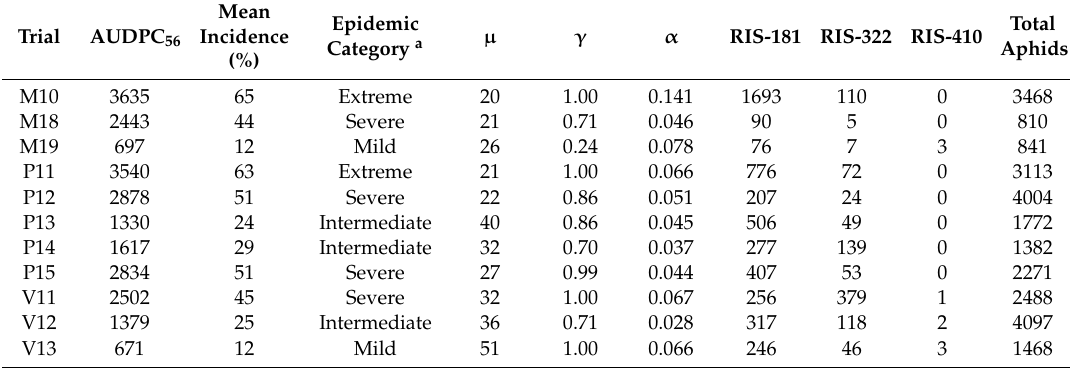
Table 2. CABYV epidemics and winged aphid abundances in melon crops in eleven field trials conducted in Avignon between 2010 and 2019. Epidemics are summarized by their area under the disease progress curve calculated over 56 days (AUDPC 56 ), mean incidence (AUDPC 56 / 56), epidemic category and parameter estimates of the logistic models ( µ , γ and α ) fitted to cumulative incidences. Aphis gossypii (RIS-181), Myzus persicae (RIS-322), Macrosiphum euphorbiae (RIS-410) and total aphid abundances were monitored with suction traps between 1 and 55 days after